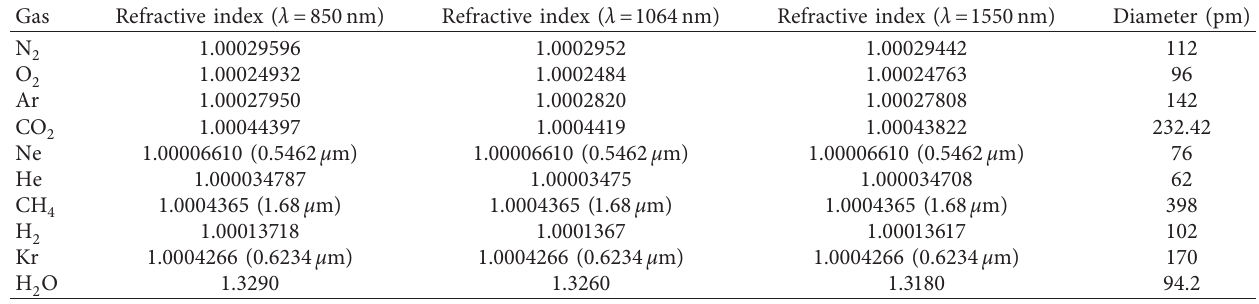
Table 1: Refractive indices and diameters of atmospheric